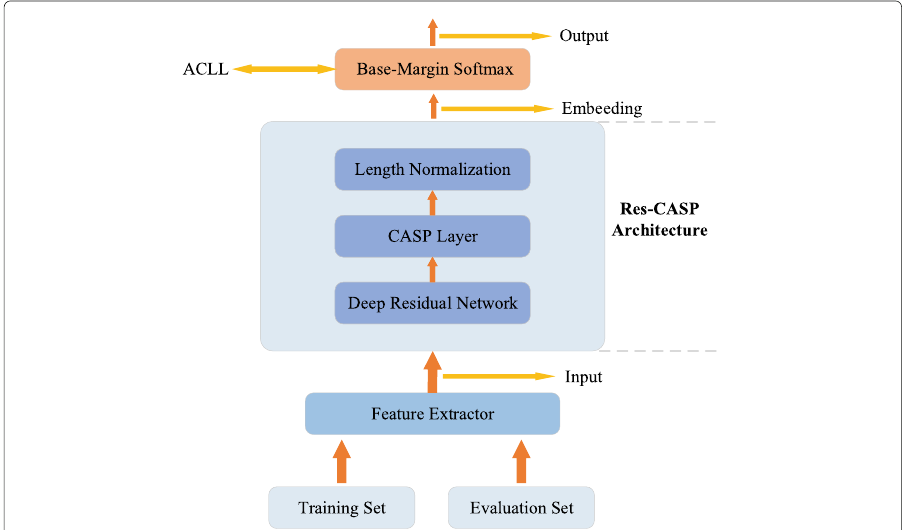
Fig. 1 The proposed text-independent speaker recognition